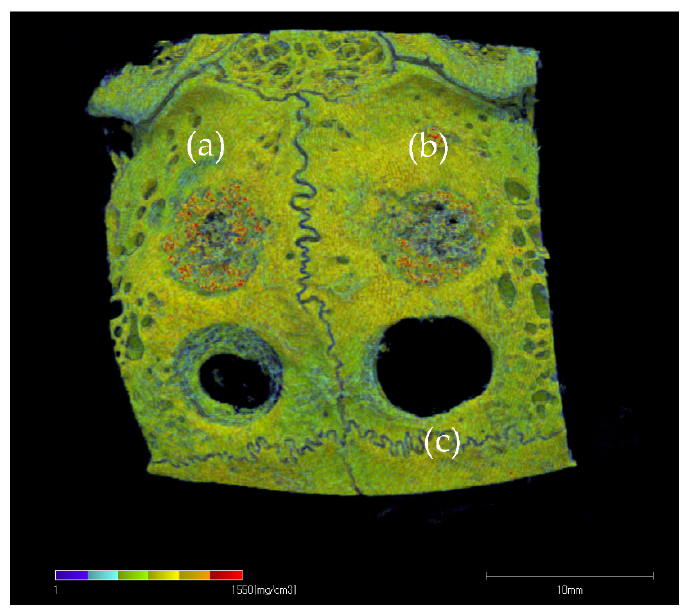
Figure 12. BMD image: ( a ) biphasic HA granules, ( b ) HA granules, ( c ) bone defect.